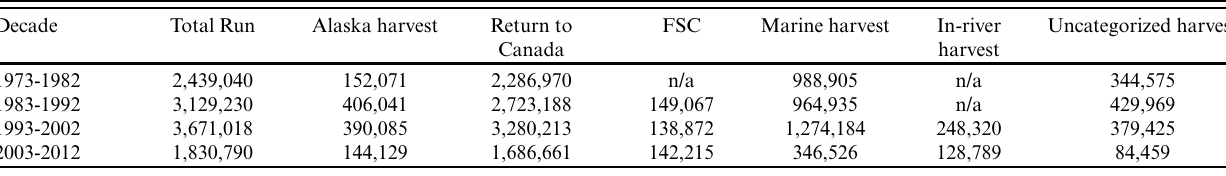
Table 1 . Skeena River sockeye salmon ( Oncorhynchus nerka ) harvest trends, 1973-2012 (Pacific Salmon Commission 2011, 2012, English 2012, English et al. 2012; Skeena Salmon Program 2012, unpublished data ). FSC is First Nations’ harvest for food, social, and ceremonial